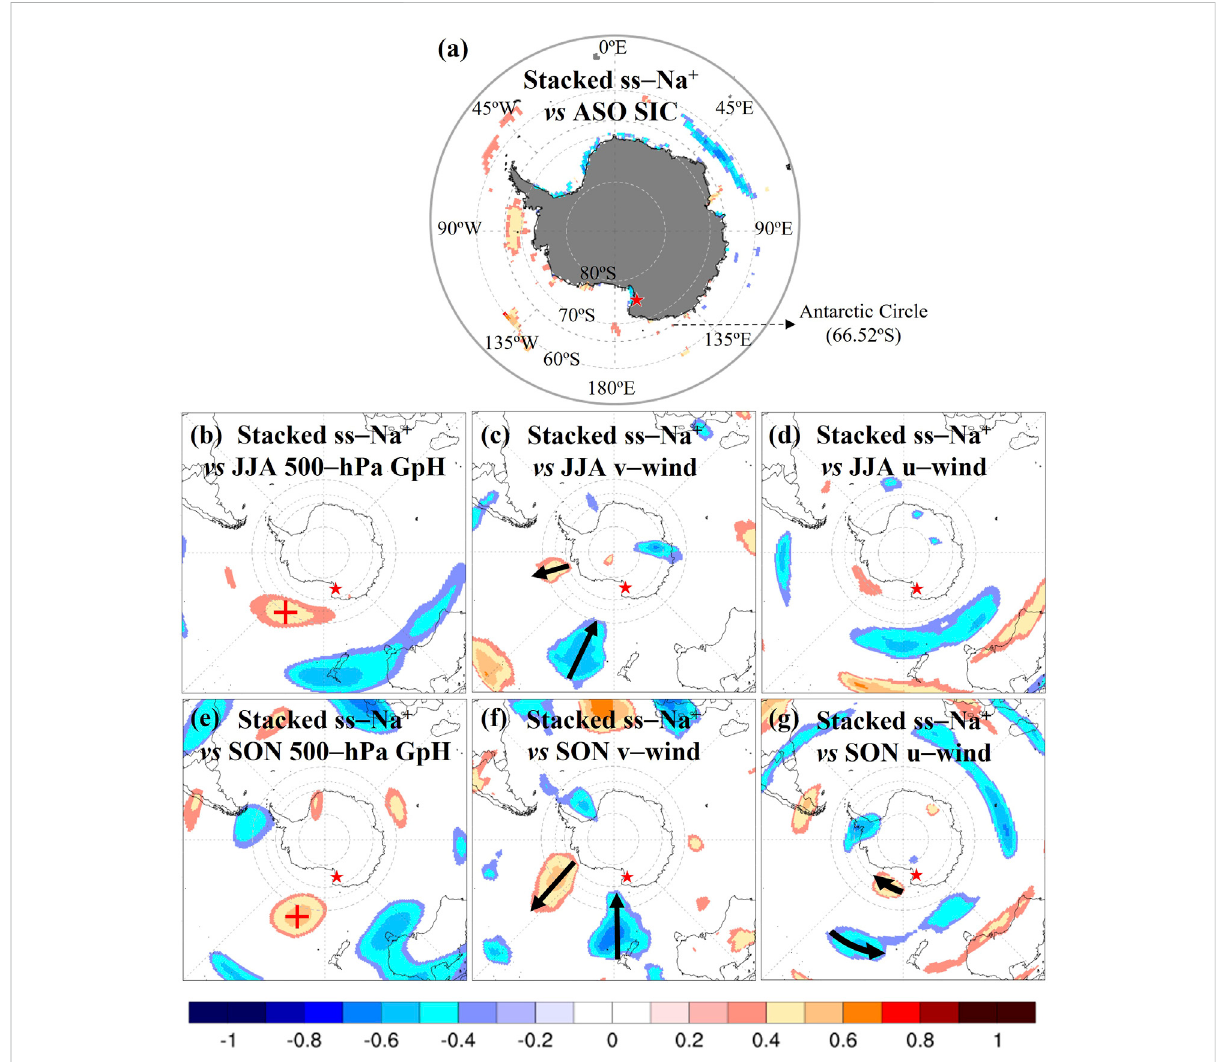
Maps of spatial correlation analysis between the stacked ss – Na + record and (A) ASO SIC, (B) JJA 500 – hPa GpH, (C) JJA 10 m v – wind, (D) JJA 10 m u – wind, (E) SON 500 – hPa GpH, (F) SON 10 m v – wind, and (G) SON 10 m u – wind across the Southern Ocean and Antarctica at the 90% signi fi cance level (see Supplementary Section S1). Red stars represent the location of the SGP. The red crosses in (B) and (E) indicate the PSA2 position. The black arrows in (C) , (F) , and (G) are wind vectors indicating the direction and intensity of the wind. Pearson ’ s correlation coef fi cients on maps are given by the intensity of shading, as displayed in a color scale bar at the bottom. The correlation analysis was performed using a Climate Reanalyzer (http://ClimateReanalyzer.org), Climate Change Institute, University of Maine, United